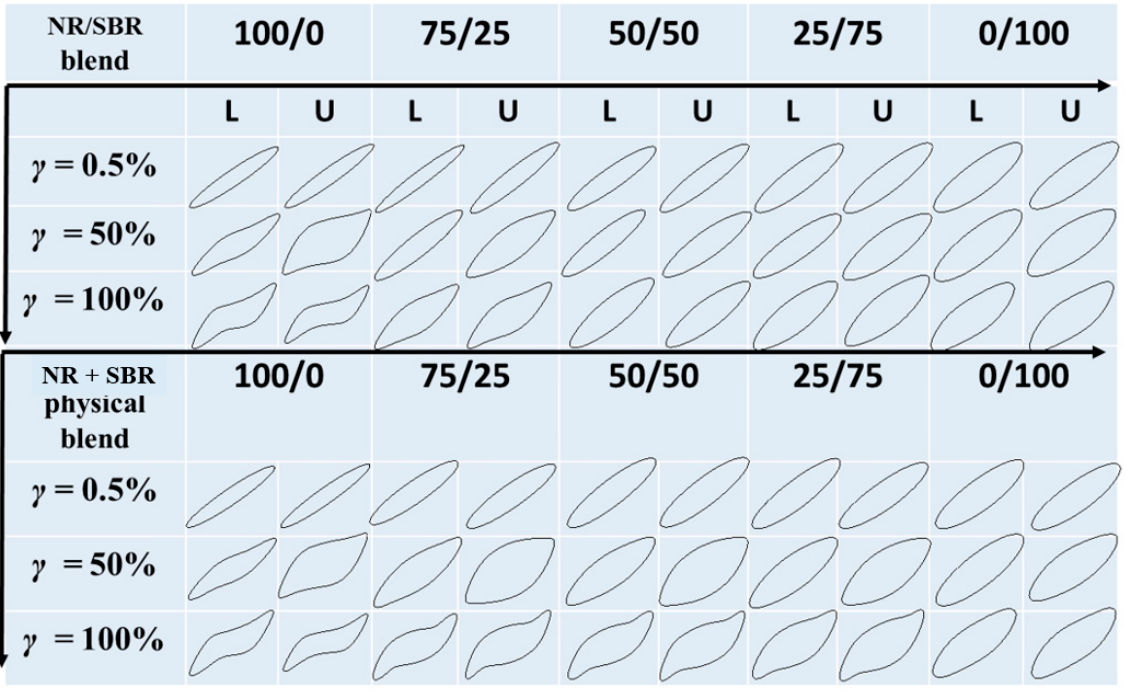
Figure 9. Normalized Lissajous curves generated from oscillatory shearing measurements at different strain amplitudes for NR/SBR blends and NR + SBR physical blends at 100 °C and 1 rad/s. Here, L represents loading and U represents unloading.